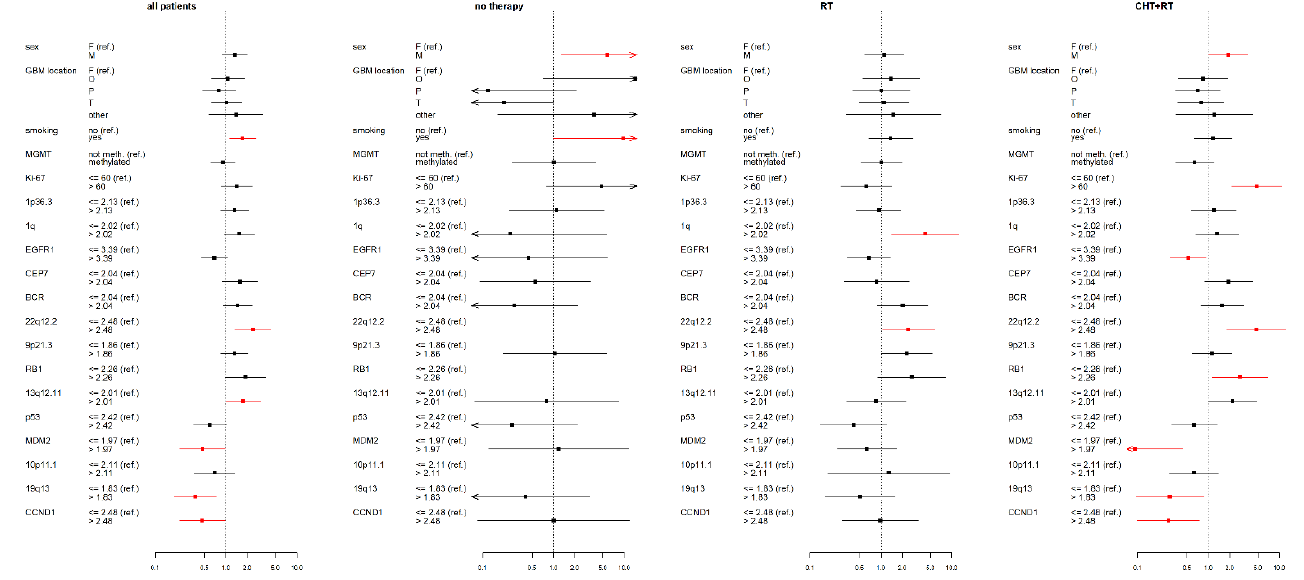
Figure 3. Results of the multivariate Cox proportional hazard models of progression-free survival (PFS) for studied variables (selected clinical factors and molecular markers) in therapy subgroups, expressed using a hazard ratio (a square point—the point estimation, a line segment corresponding to the 95% confidence interval; in case of wider interval than presented scale the arrow is used) for each level of presented factors. The reference category of each factor is labeled with “(ref.)”. Each factor was analyzed in a separate model with adjusting variables—categorized age and Karnofsky score (HRs are not presented). Significant results ( p < 0.05) are shown in red; the dotted line indicates a hazard ratio of 1. RT—radiotherapy; CHT+RT—chemoradiotherapy; F—female; M—male; F—frontal; O—occipital; P—parietal; T—temporal; BCR—breakpoint cluster region; EGFR1—epidermal growth factor receptor 1; RB1—retinoblastoma gene 1; TP53—tumor protein P53;